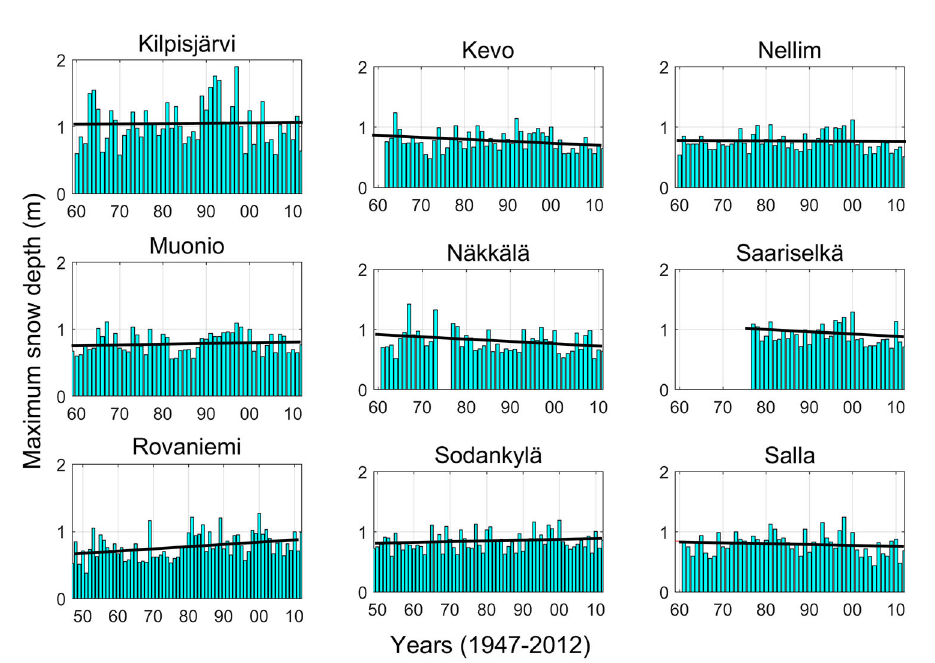
Fig. 4. Long-term variations in maximum annual snow depth at the Lapland sites.